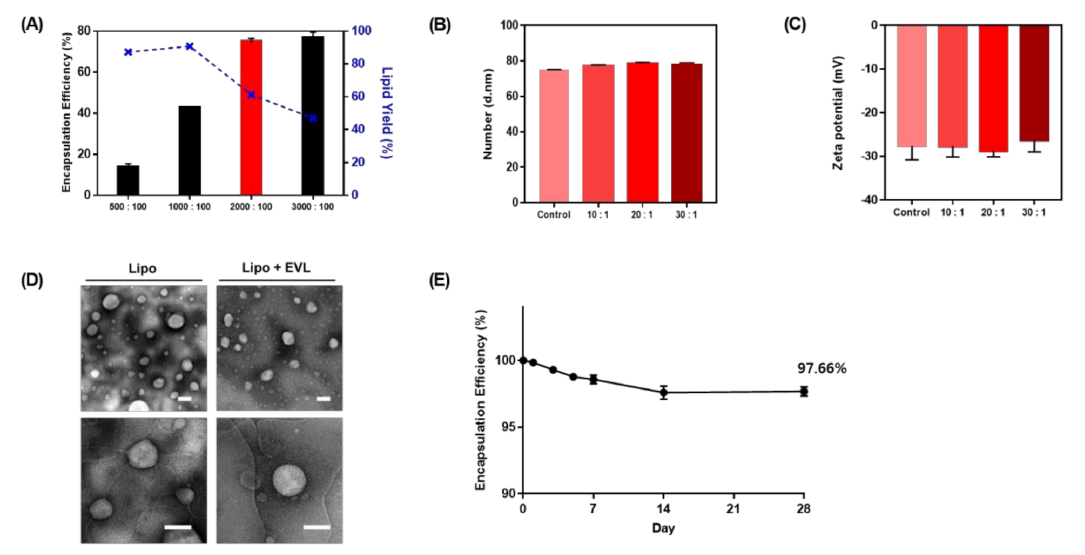
Figure 2. Characterization of liposome. ( A ) Analysis of encapsulation efficiency and drug encapsulation yield according to the ratio of lipid to drug. The ratio indicates Lipid:Drug. ( B ) Size and ( C ) Zeta potential of drug-loaded liposome depending on the ratio of lipid to drug. ( D ) TEM images of Lipo and Lipo + EVL (Scale bars equal to 100 nm). ( E ) The stability of Lipo + EVL for 28 days in PBS solution. Values are presented as mean ± SD ( n = 3). Lipo: Liposome; Lipo + EVL: Everolimus (EVL)-loaded